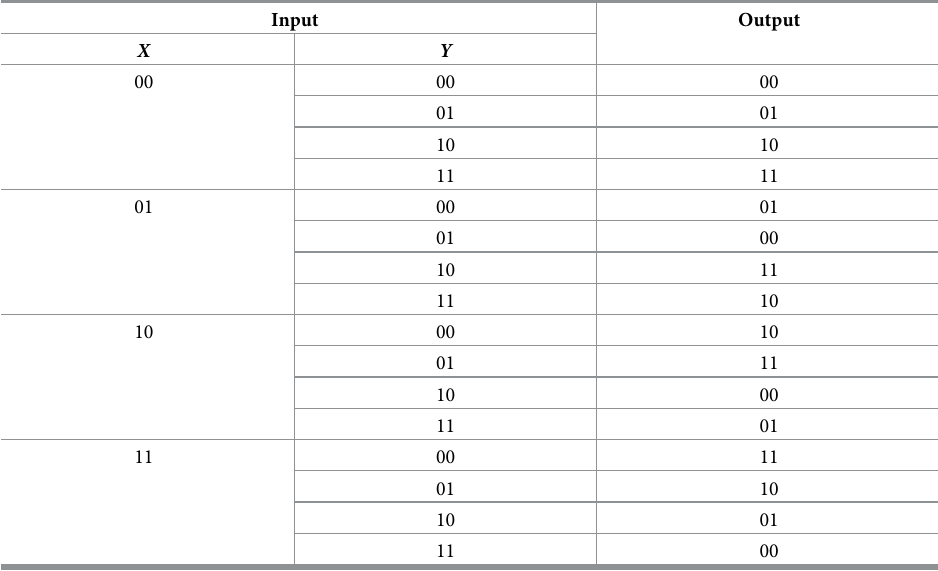
Table 3. Truth table of double-bit